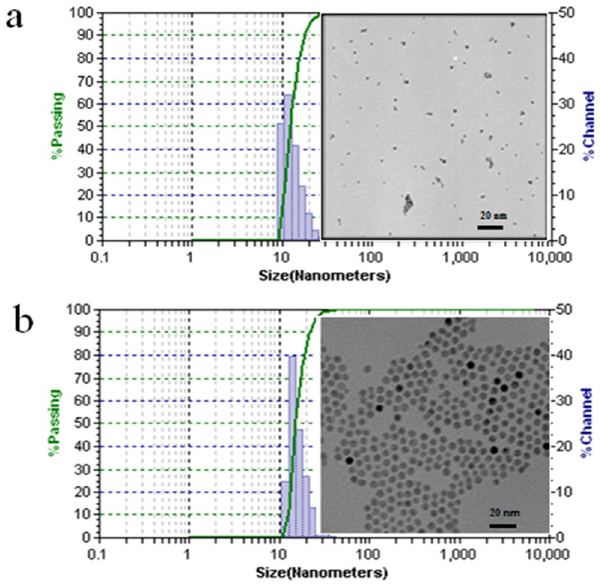
Figure 1. Characterizations of amphiphilic polymers coated AgNPs ( a ) and AuNPs ( b ) (TEM and DLS).